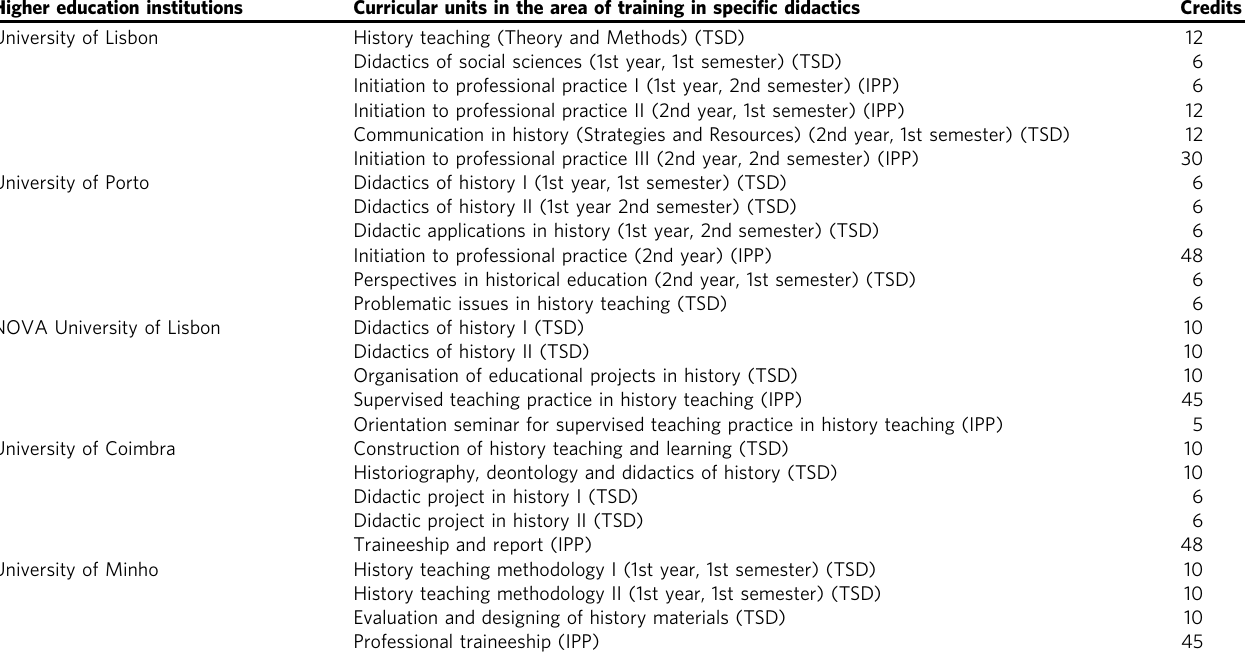
Table 1 Curricular units of speci fi c didactics (TSD) and initiation to pedagogical practice (IPP) of MDHTs offered by higher education institutions in